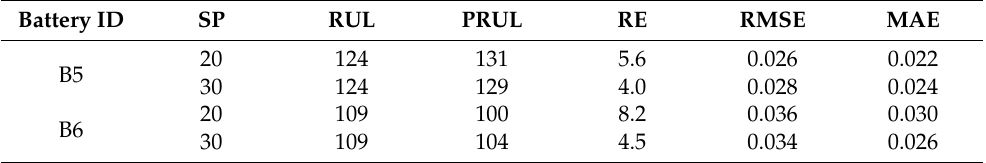
Figure 11. RUL prediction results of the proposed method for NASA batteries under different starting points: ( a ) B5; ( b ) B6. Table 2. Performance on the NASA dataset.